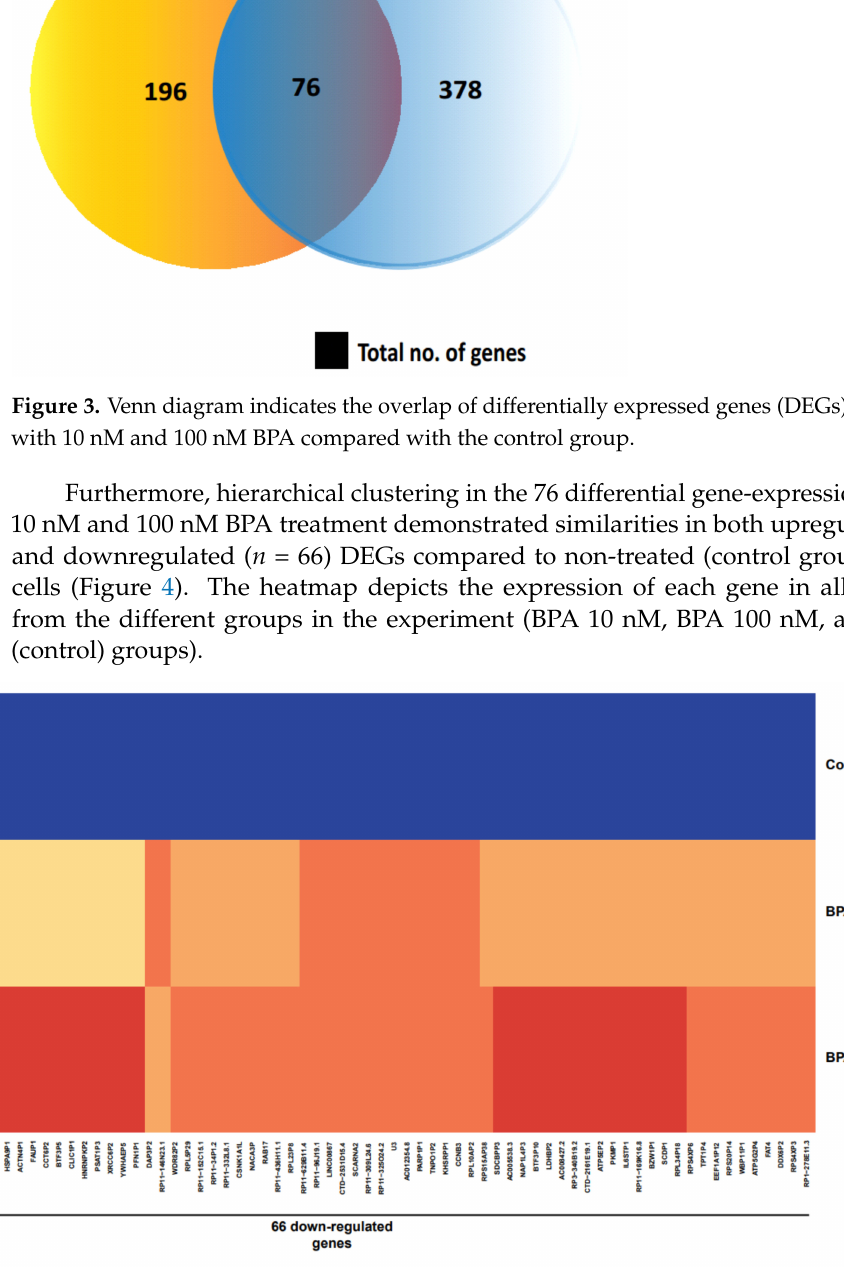
Figure 4. Heatmap reproduced expression profile for genes differently regulated ( p < 0.05) over two used BPA doses (10 nM and 100 nM) and control group. Dark blue indicates low expression, and deep red indicates high